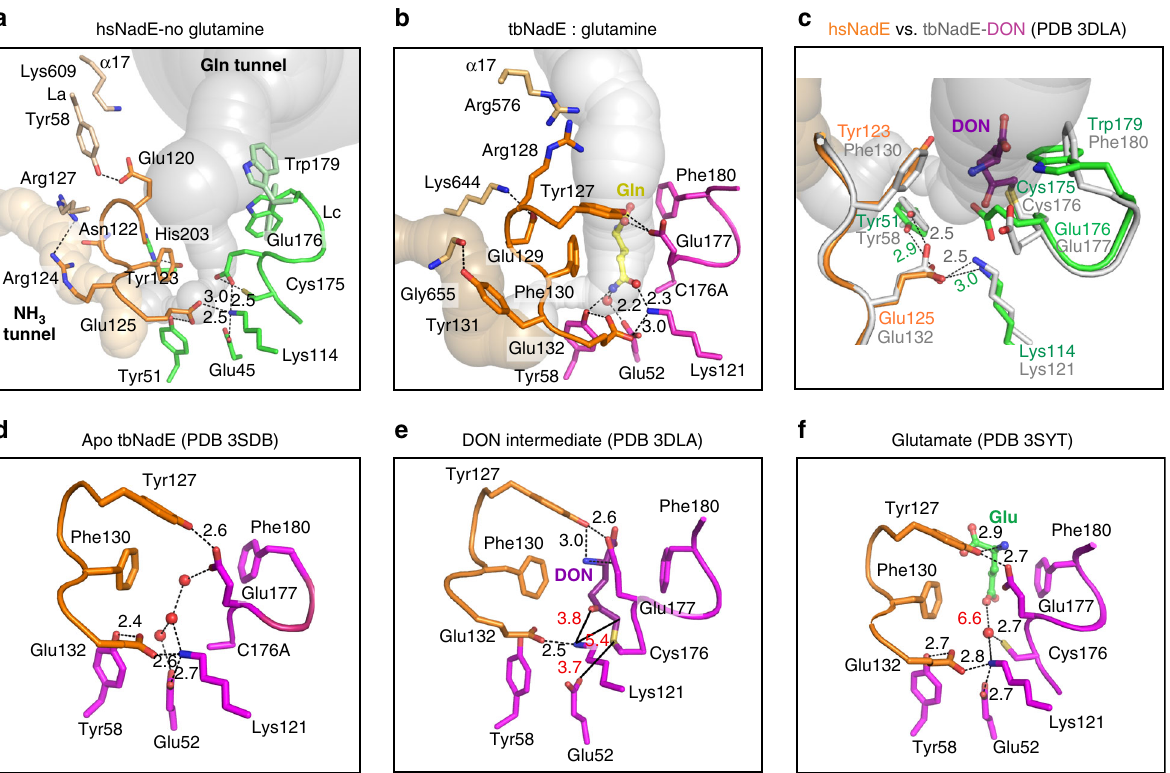
Fig. 5 Role of the YRE loop and arrangement of the glutaminase active site. a This panel illustrates the hsNadE glutaminase domain with the glutaminase active site free of ligand in a complex with the synthetase active site fully occupied with the intermediate analog. b The glutaminase active site of tbNadE subunit D is occupied with glutamine in a complex with SFIs and PPi bound in the synthetase active site of the coupled subunit B. The YRE loop residues are shown in orange sticks in all complexes, the catalytic and substrate-binding residues are shown in green in hsNadE and purple in tbNadE. The glutamine substrate and water in the ammonia tunnel of the tbNadE complex are shown as a yellow stick and red sphere. c Overlay of the hsNadE and tbNadE – DON complexes (PDB code 3DLA). Distance of hydrogen bonding between (i) YRE loop ’ s glutamate and catalytic lysine and (ii) the glutamate and constriction 1 ’ s tyrosine is shown as green (hsNadE) and gray (tbNadE) numbers. d – f The glutaminase active site of previously reported tbNadE structures bound to waters in the apo form (PDB code 3SDB) ( d ), with DON bound (dark purple stick, PDB code 3DLA) ( e ), and with glutamate bound (green stick, PDB code 3SYT ( f